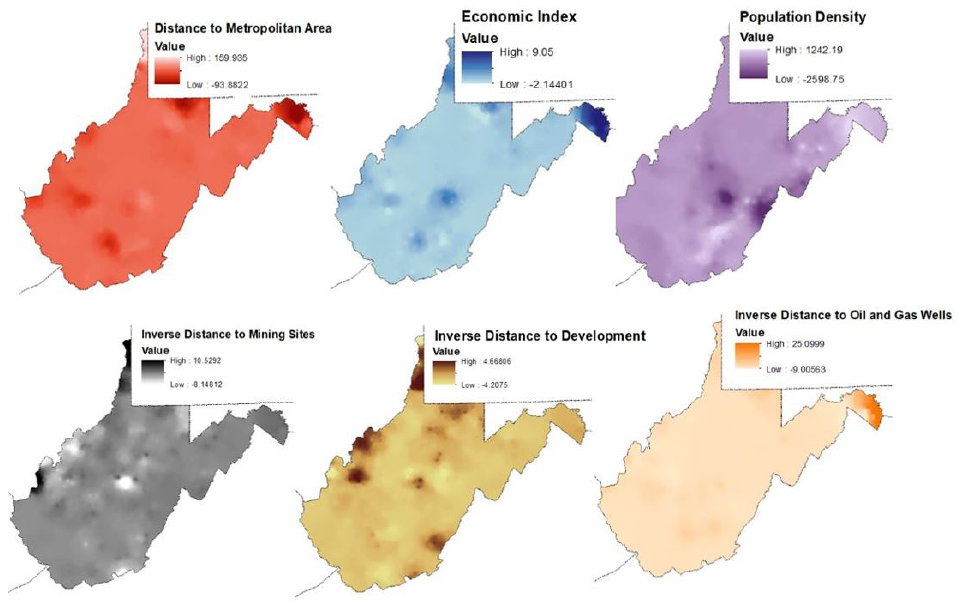
Figure 11. Geographic Coefficients for the 1995 −